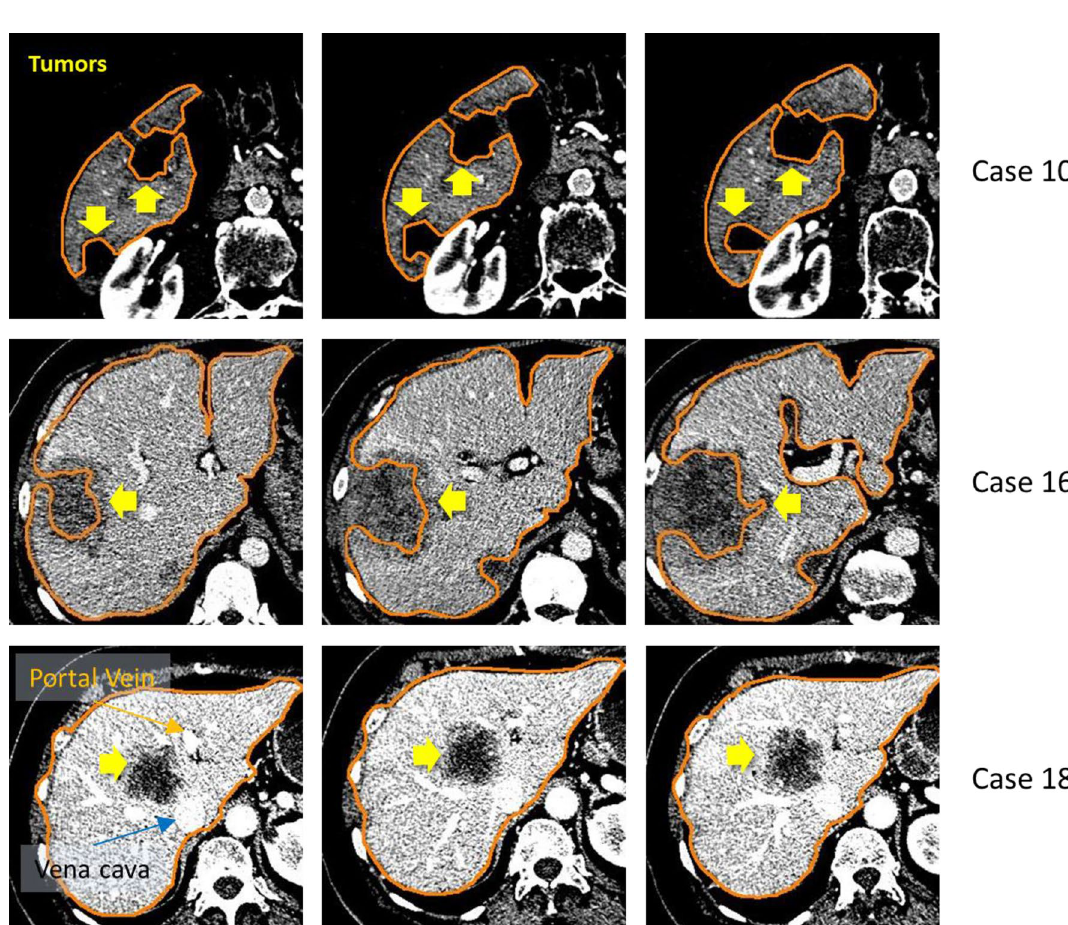
Figure 15. Segmentations of diseased livers. For the case number 18 (included in Table 4 but not in Table 9), the lesion was relatively small and located inside the liver, near vena cava and portal vein